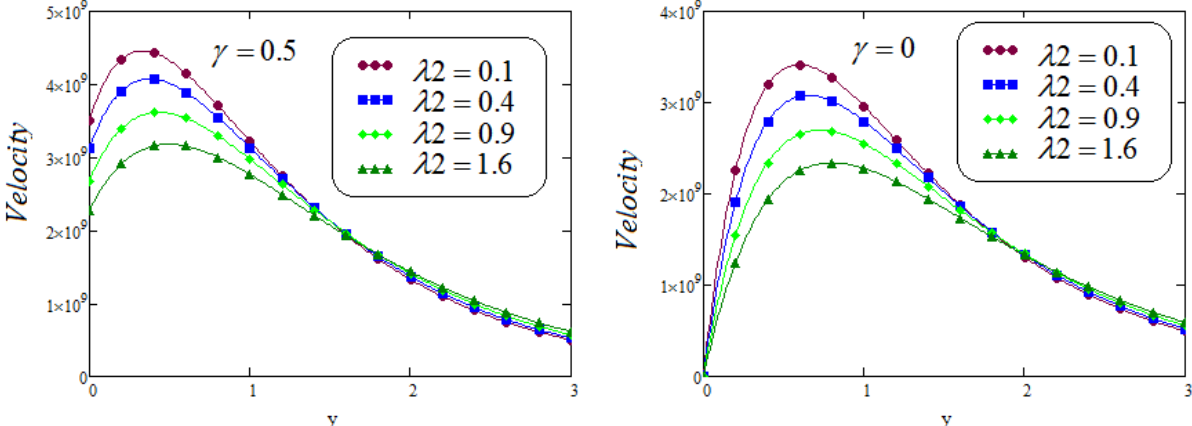
Figure 7. Velocity field under slip conditions as well as the velocity field under no-slip conditions for different λ 2 values when f ( t ) = e at , a = 0.25, t = 1.5, Gr = 3.5, λ 1 = 0.6, Pr = 0.71, M = 2.